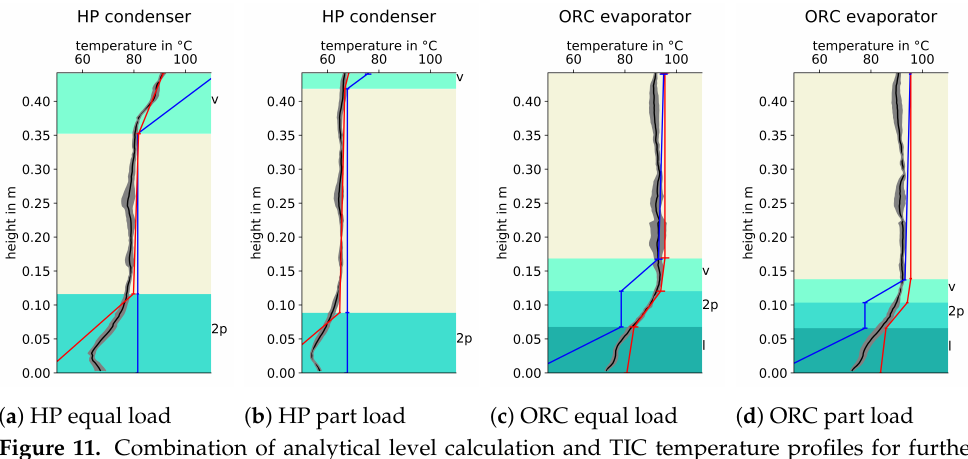
Figure 11. Combination of analytical level calculation and TIC temperature profiles for further operation points (legend see Figure